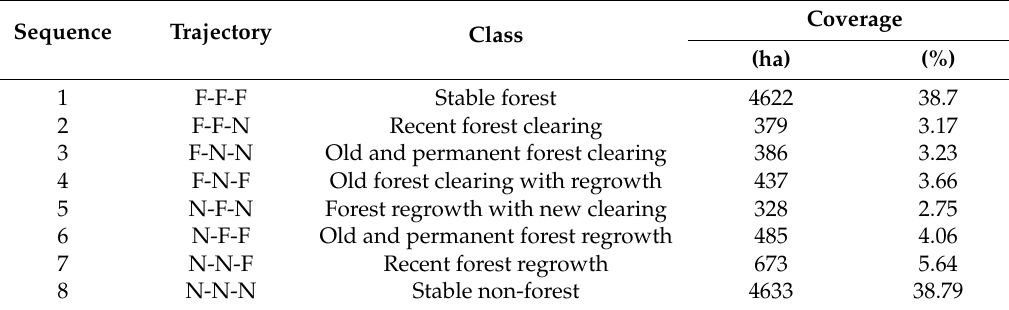
Table 8. Estimated area (ha) and proportion (%) of forest cover change trajectories in Phewa Lake watershed from 1995 to 2017.